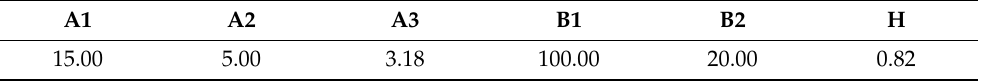
Figure 1. Photo of the tensile machine for in situ X-ray tomography study of samples under load ( left ). The setup and drawing of the CFRP sample ( right ). Table 1. Dimensions of the CFRP specimens in the mechanical tests. Accuracy is ± 0.01 mm.